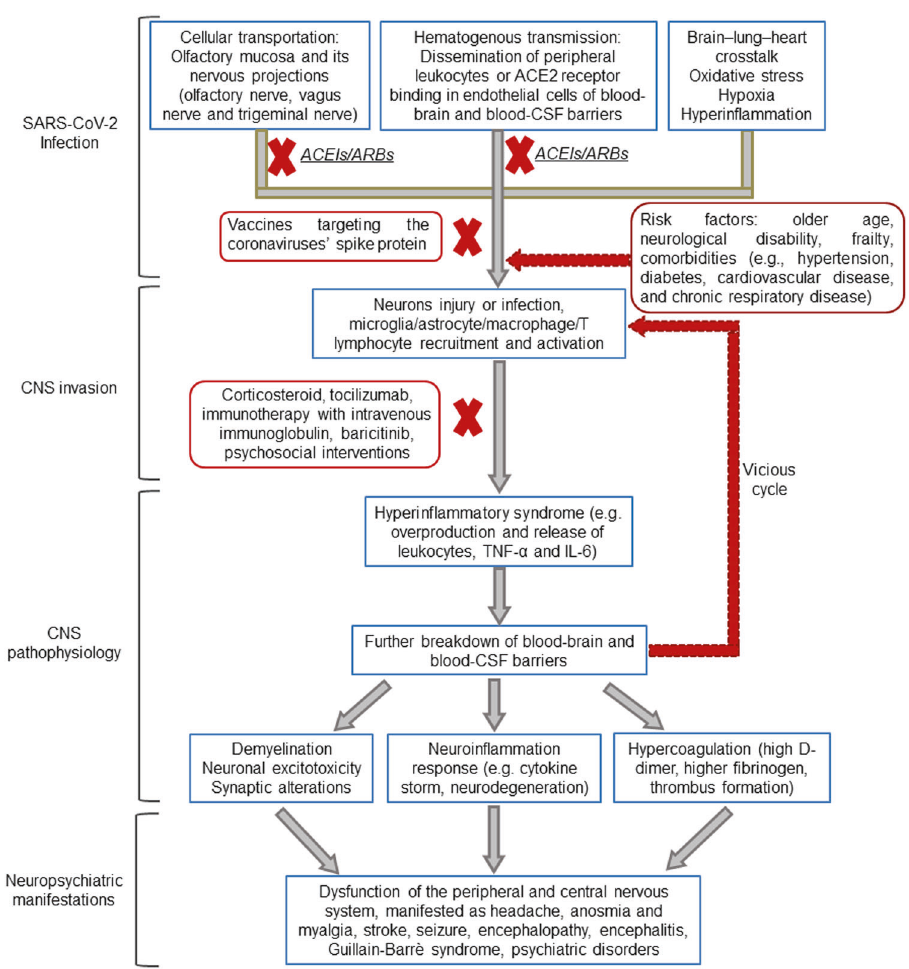
Fig. 1 Neuropsychiatric manifestations, possible mechanisms of neurological impairments after SARS-CoV-2 infection, and potential therapeutic